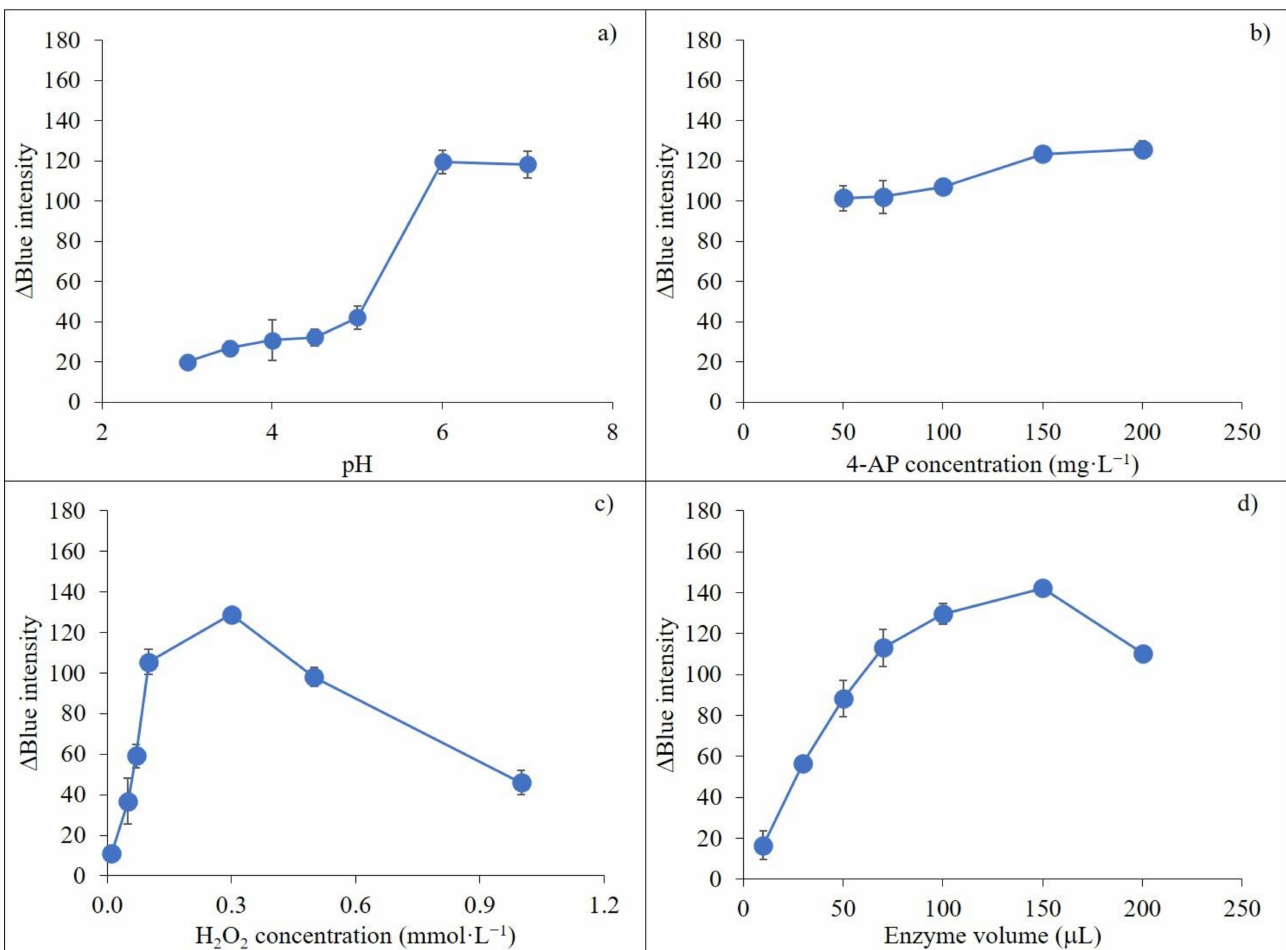
Figure 2. Investigation of various carbaryl detection parameters based on peroxidase enzymatic reaction; ( a ) effect of pH; ( b ) effect of 4-AP concentration; ( c ) effect of hydrogen peroxide concentration and ( d ) effect of enzyme volume on sensitivity of carbaryl detection by peroxidase enzymatic